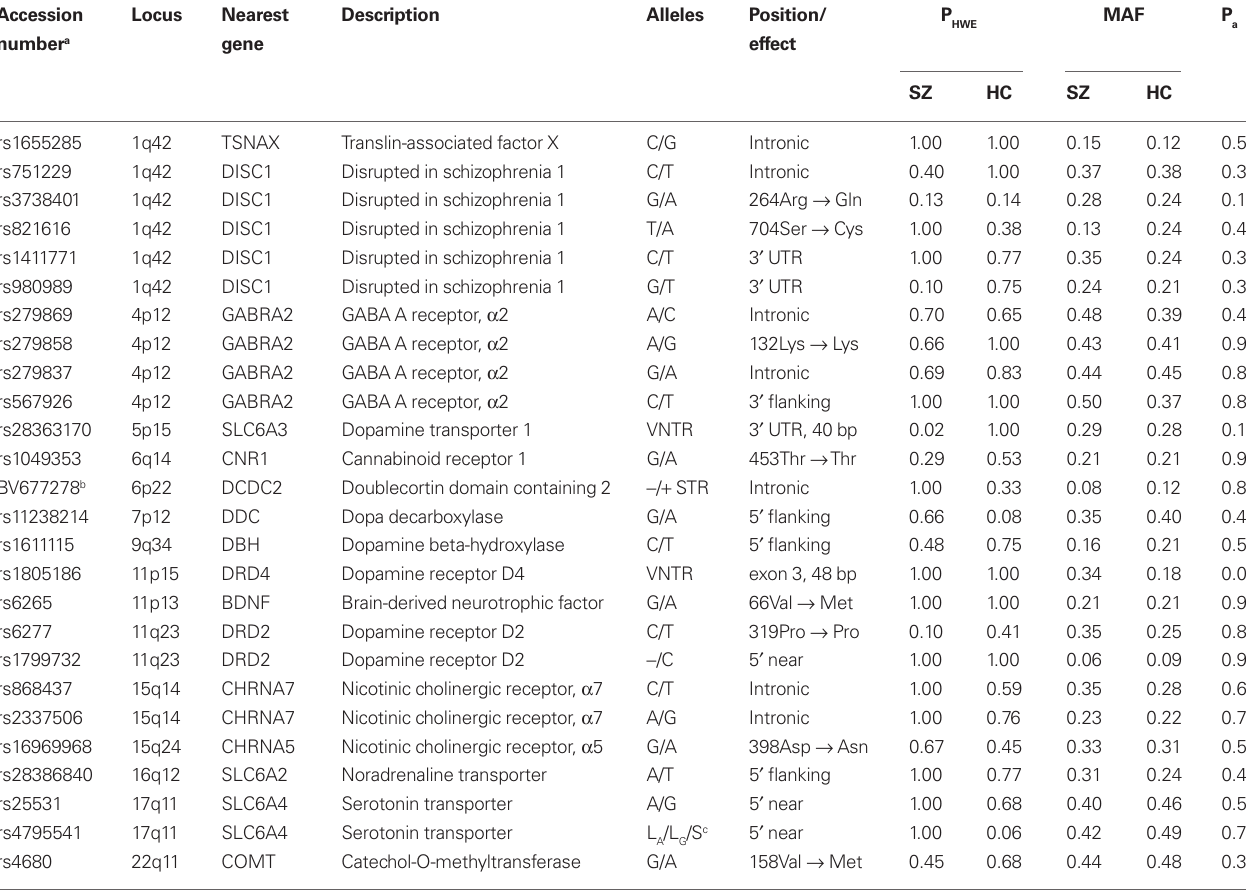
Table 2 | Genotyped polymorphic